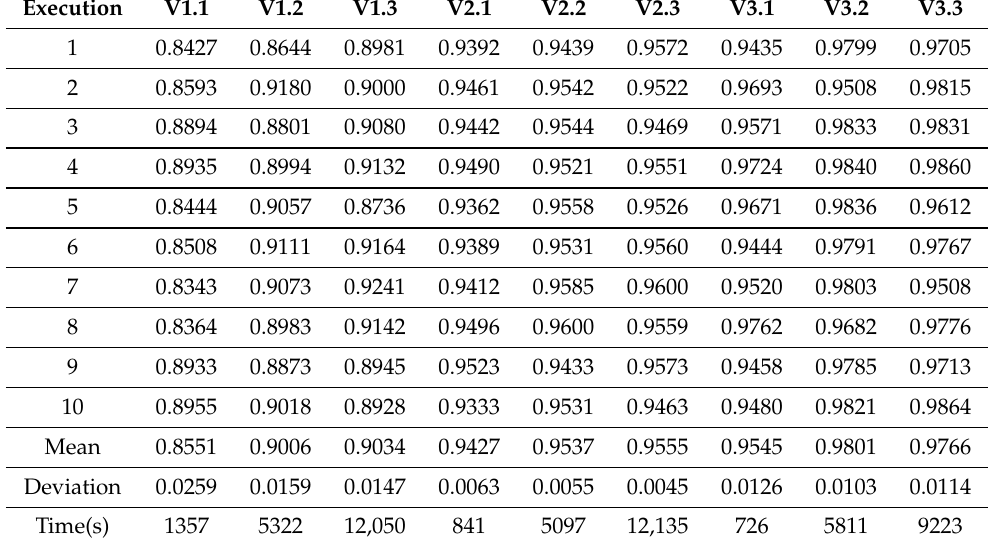
Table 5. Determination coefficient R 2 .